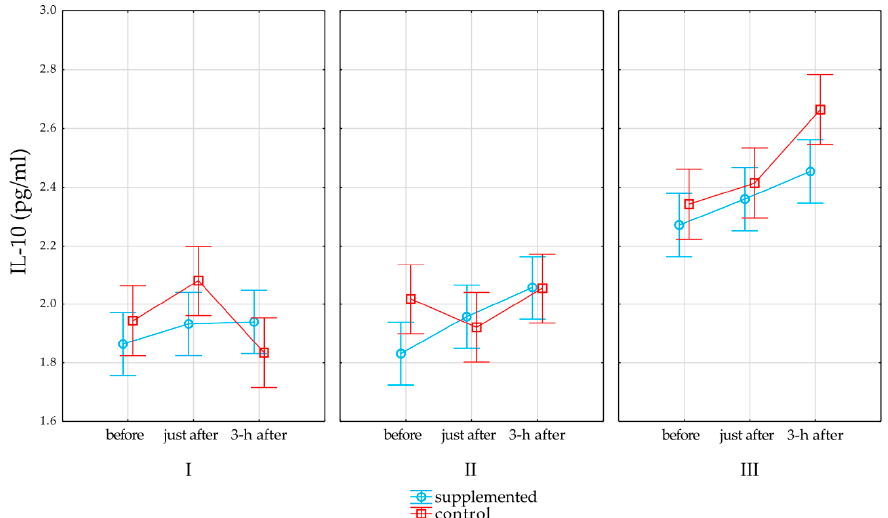
Figure 2. Effects of supplementation on interleukin (IL)-10. Red line denotes changes in the control group, and light blue line denotes changes in the supplemented group. Whiskers denote standard error, while open rectangles for the control group and open circles for the supplemented group denote mean value.